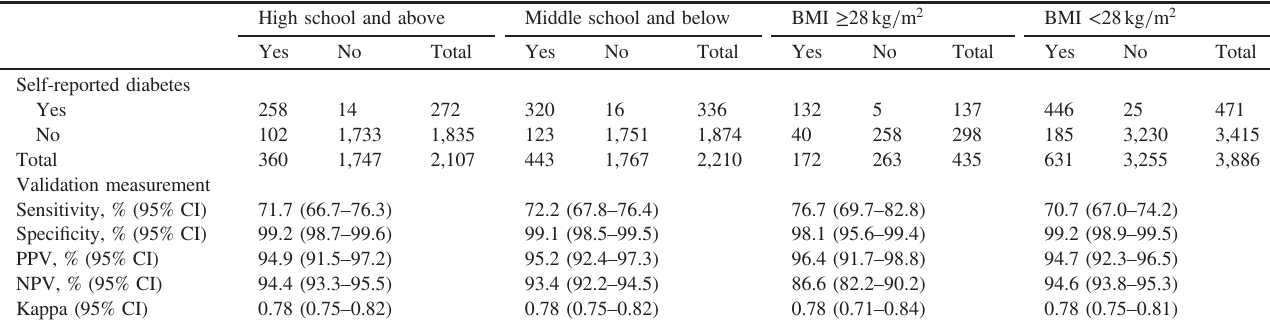
BMI, body mass index; CI, con fi dence interval; FPG, fasting plasma glucose; NPV, negative predictive value; PPV, positive predictive value. Data for sensitivity, speci fi city, PPV, and NPV are shown as percentages (95% con fi dence intervals). Data for Kappa is shown as Kappa value (95% con fi dence interval).